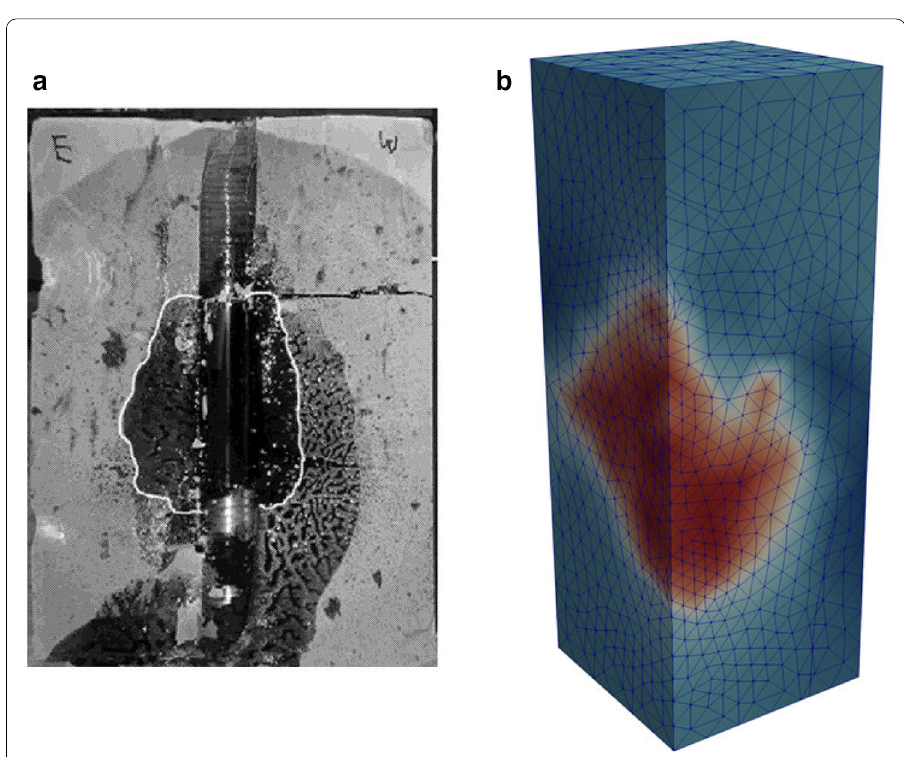
Fig. 4 Laboratory test. Comparison between the experimental and the numerical results in terms of extension of the damage induced by the fluid pressure. a Extension of the damaged zone observed in the experiments [4]. b Visualization of the distribution of the damage in terms of magnitude (dark red color corresponds to 0.5 mm) of the opening displacements as obtained from the numerical simulation, on a quarter of the numerical model showing the different extension of damage on the symmetry planes